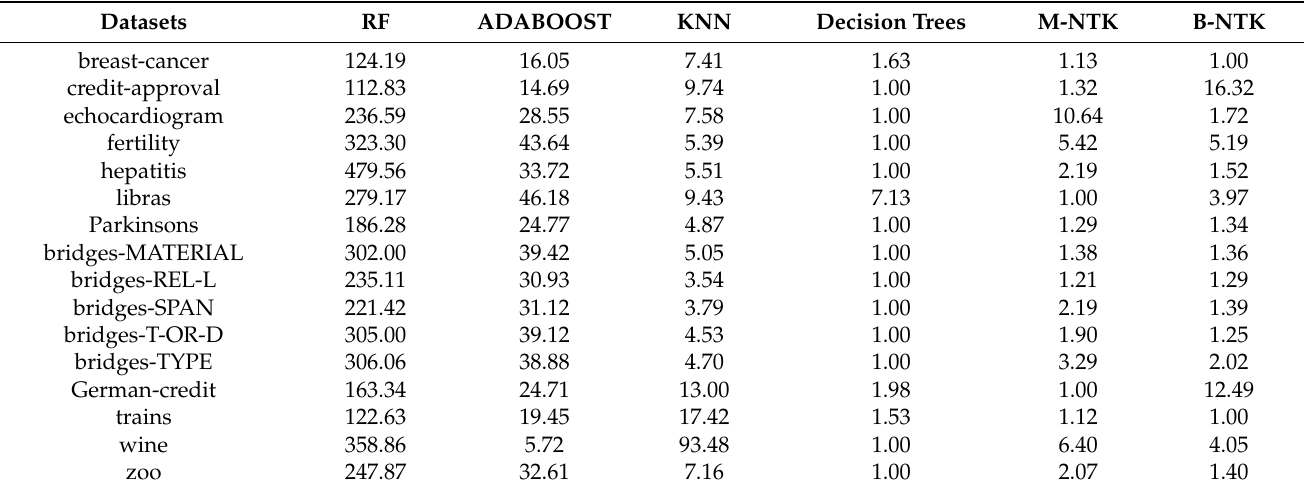
Table 5. Time-Comparison between our model and commonly used standard